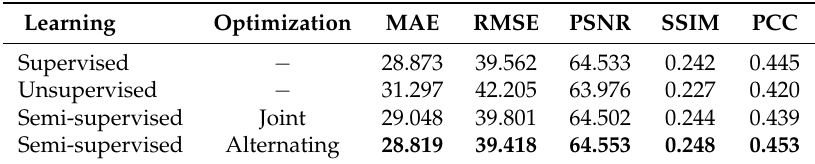
Table 6. Comparison between different learning and optimization methods. The best scores are displayed in bold. PCC, Pearson correlation